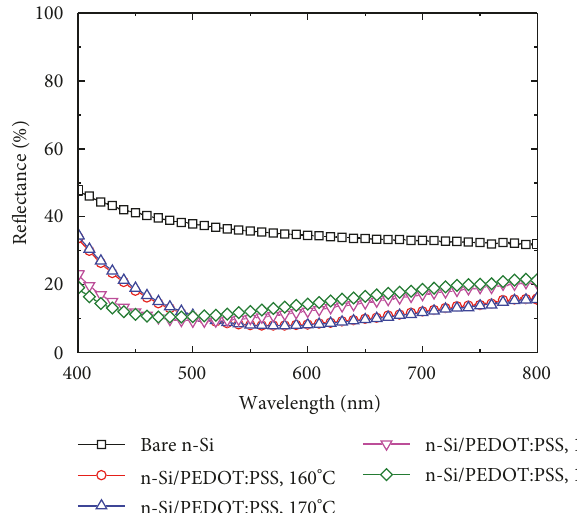
Figure 5: Re fl ectance spectra of n-Si/PEDOT:PSS samples annealed at di ff erent temperatures from 160 ° C to 190 ° C, and the re fl ectance spectrum of the polished bare n-Si is also shown for a